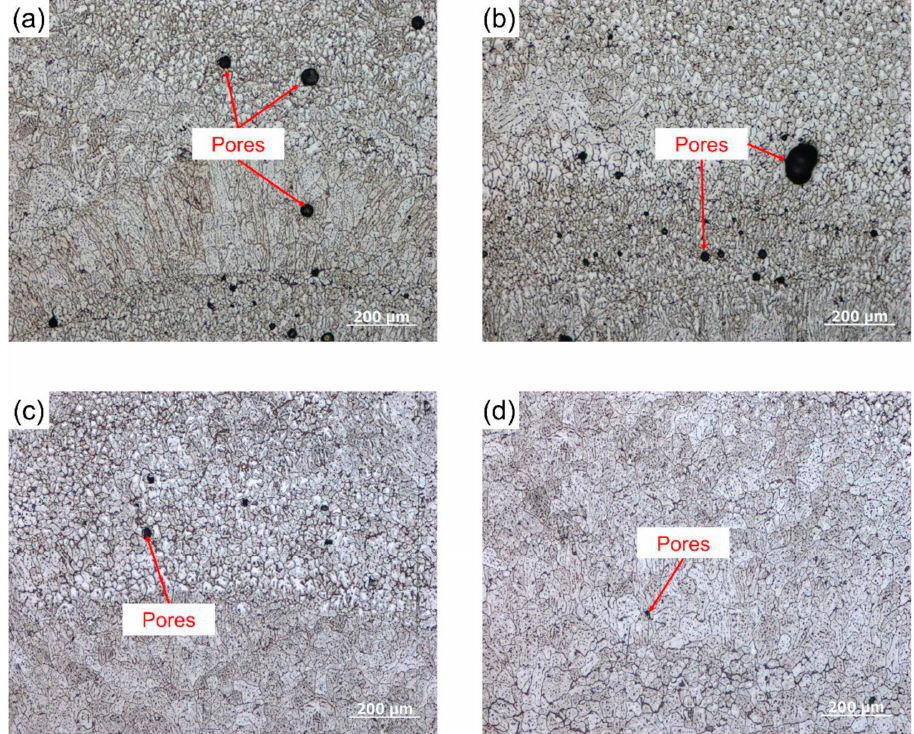
Figure 11. Pores in the samples with the different interlayered ultrasonic peening times: ( a ) no ul- trasonic peening; ( b ) ultrasonic peening once; ( c ) ultrasonic peening twice; ( d ) ultrasonic peening three times, reproduced or adapted from [105], with permission from Elsevier, 2022. Table 4. Pores of samples with the different interlayered ultrasonic peening times [81].